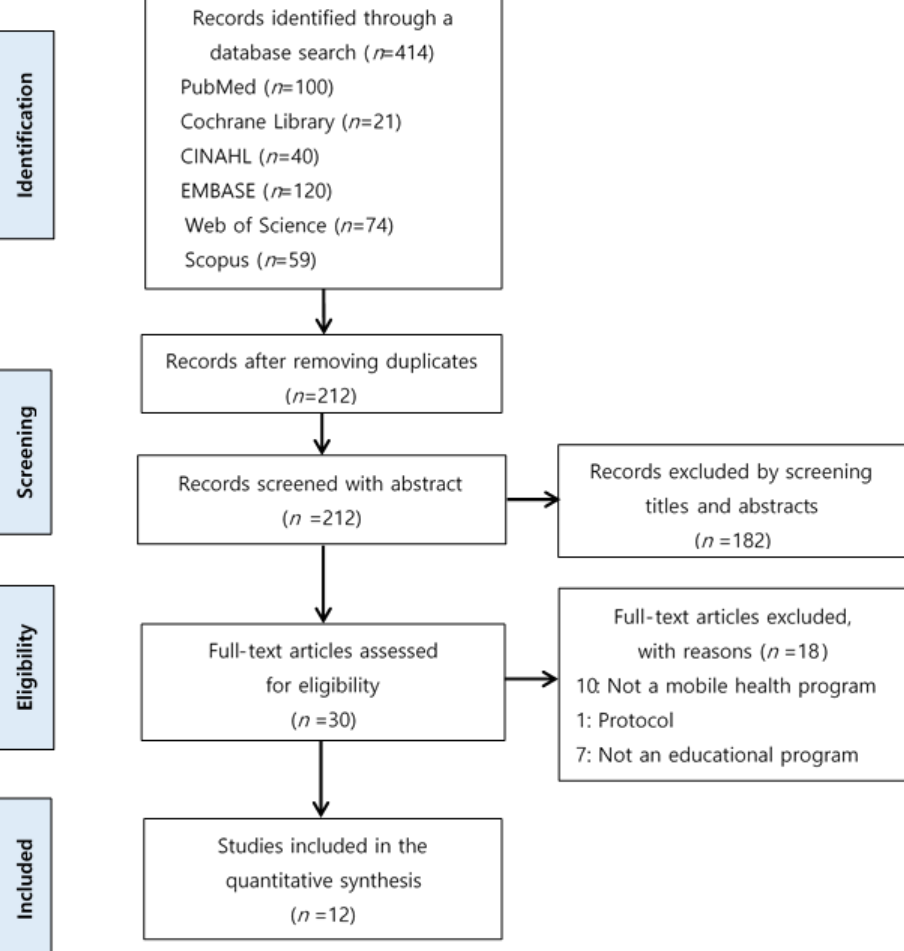
Figure 1. Preferred Reporting Items for Systematic Reviews and Meta-Analyses (PRISMA) flow diagram of the literature search.